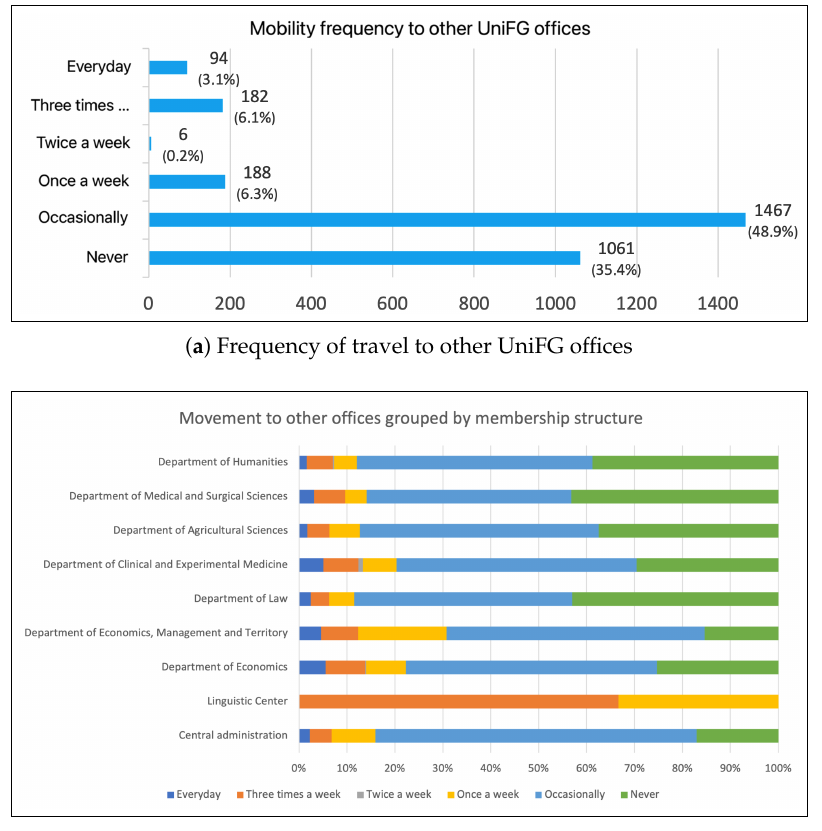
Figure 20. Transfers to other UniFG